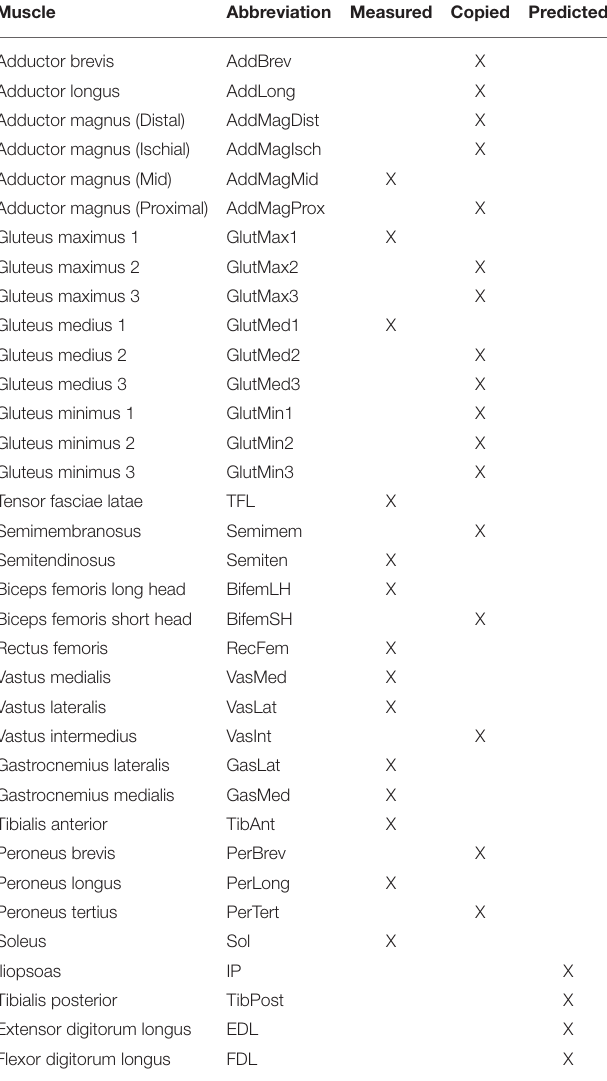
TABLE 1 | List of muscles present in each leg of the neuromusculoskeletal model, including muscles with measured EMG signals (Measured), muscles whose EMG signals were copied from neighboring muscles with similar anatomical function (Copied), and muscles whose EMG signals were predicted using synergy signals extracted from measured EMG signals